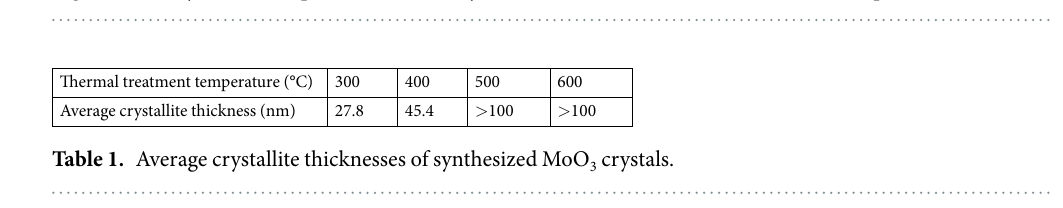
Figure 1. X-ray diffraction patterns of MoO 3 synthesized at different thermal treatment temperatures.